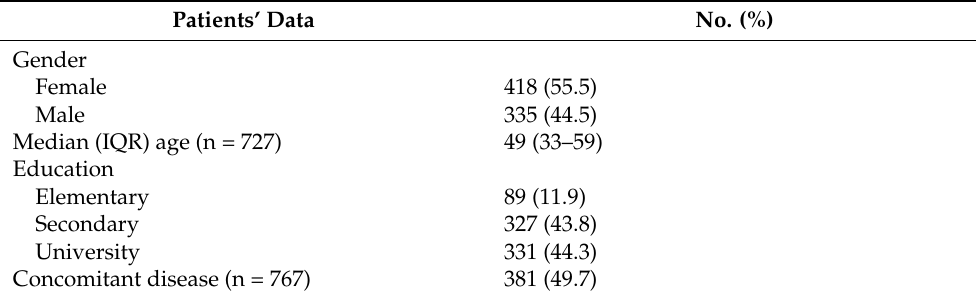
Table 1. Socio-demographic data and co-morbidities of SARS-CoV-2 notified cases in the first pandemic wave that responded to the survey.